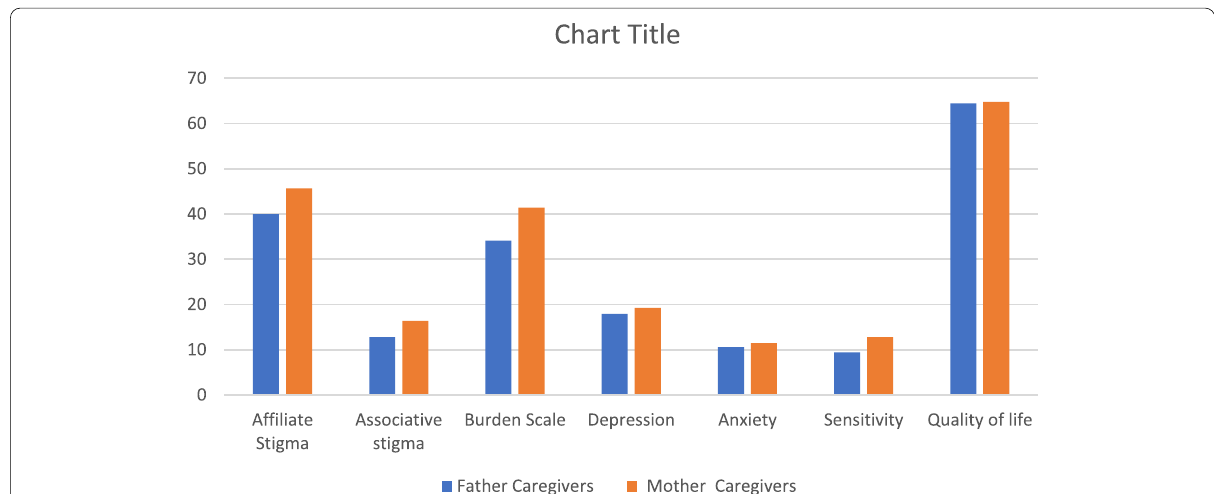
Fig. 2 Comparison of affiliate stigma and associative stigma, burden scale, and sensitivity, between father caregivers and mother caregivers of both disorders